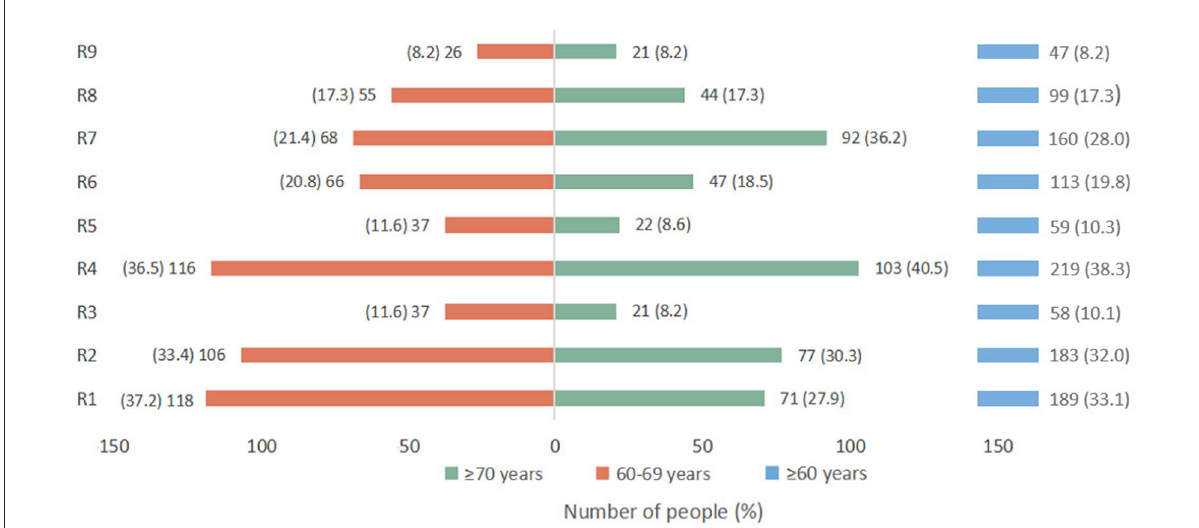
FIGURE2 Reasons for responding “no” or “not sure” when asked about willingness to accept the COVID-19 vaccine booster dose ( n = 571). “R1,” one or two doses of COVID-19 vaccines are already sufficient and a third dose is unnecessary; “R2,” the safety of the COVID-19 vaccine is not clear; “R3,” the efficacy of the COVID-19 vaccine is not clear; “R4,” severe illness and ineligibility for vaccination; “R5,” believing that they are healthy enough to fight COVID-19; “R6,” COVID-19 in China is well under control and there is no need to vaccinate; “R7,” limited movement; “R8,” believing that the vaccination process is complicated and time consuming; “R9,” other reasons.